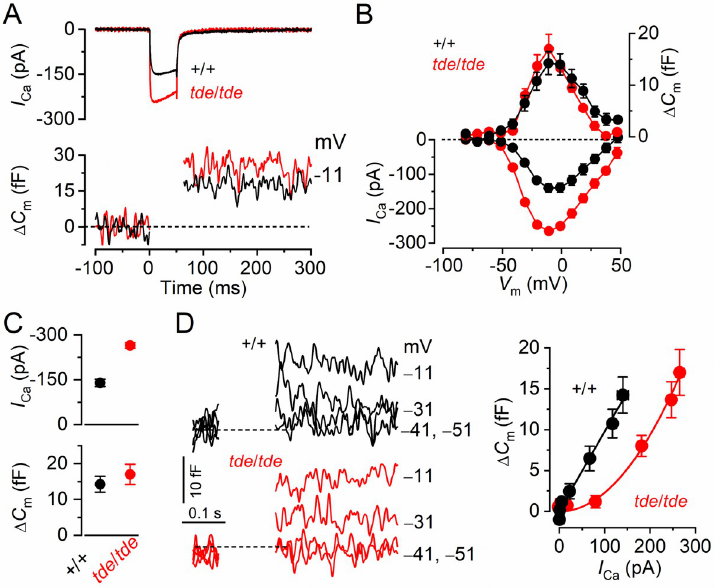
Fig 7. The properties of exocytosis in Tasmanian devil IHCs. A , I Ca and Δ C m responses from adult control and tde / tde IHCs. Recordings were obtained in response to 50 ms voltage steps, in 10 mV increments, from − 81 mV. For clarity, only maximal responses are shown. B , Average peak I Ca -voltage (left axis) and Δ C m -voltage (right axis) curves from control (P18, n = 4) and tde / tde (P18, n = 4) IHCs. C , Maximal peak I Ca (top panel) and Δ C m (bottom panel) values obtained at − 11 mV, from control and tde / tde IHCs. D , Synaptic transfer relations obtained by plotting Δ C m against the corresponding I Ca between − 71 mV and − 11 mV (the peak I Ca ) from panel B , showing that tde / tde IHCs exhibited larger I Ca values and a steeper Ca 2+ dependence of exocytosis than control cells. Fits are according to eqn.1 (see Methods). The panels on the left show average Δ C m traces from all control and tde / tde IHCs, the membrane potential is indicated next to the traces. Recordings were made at body